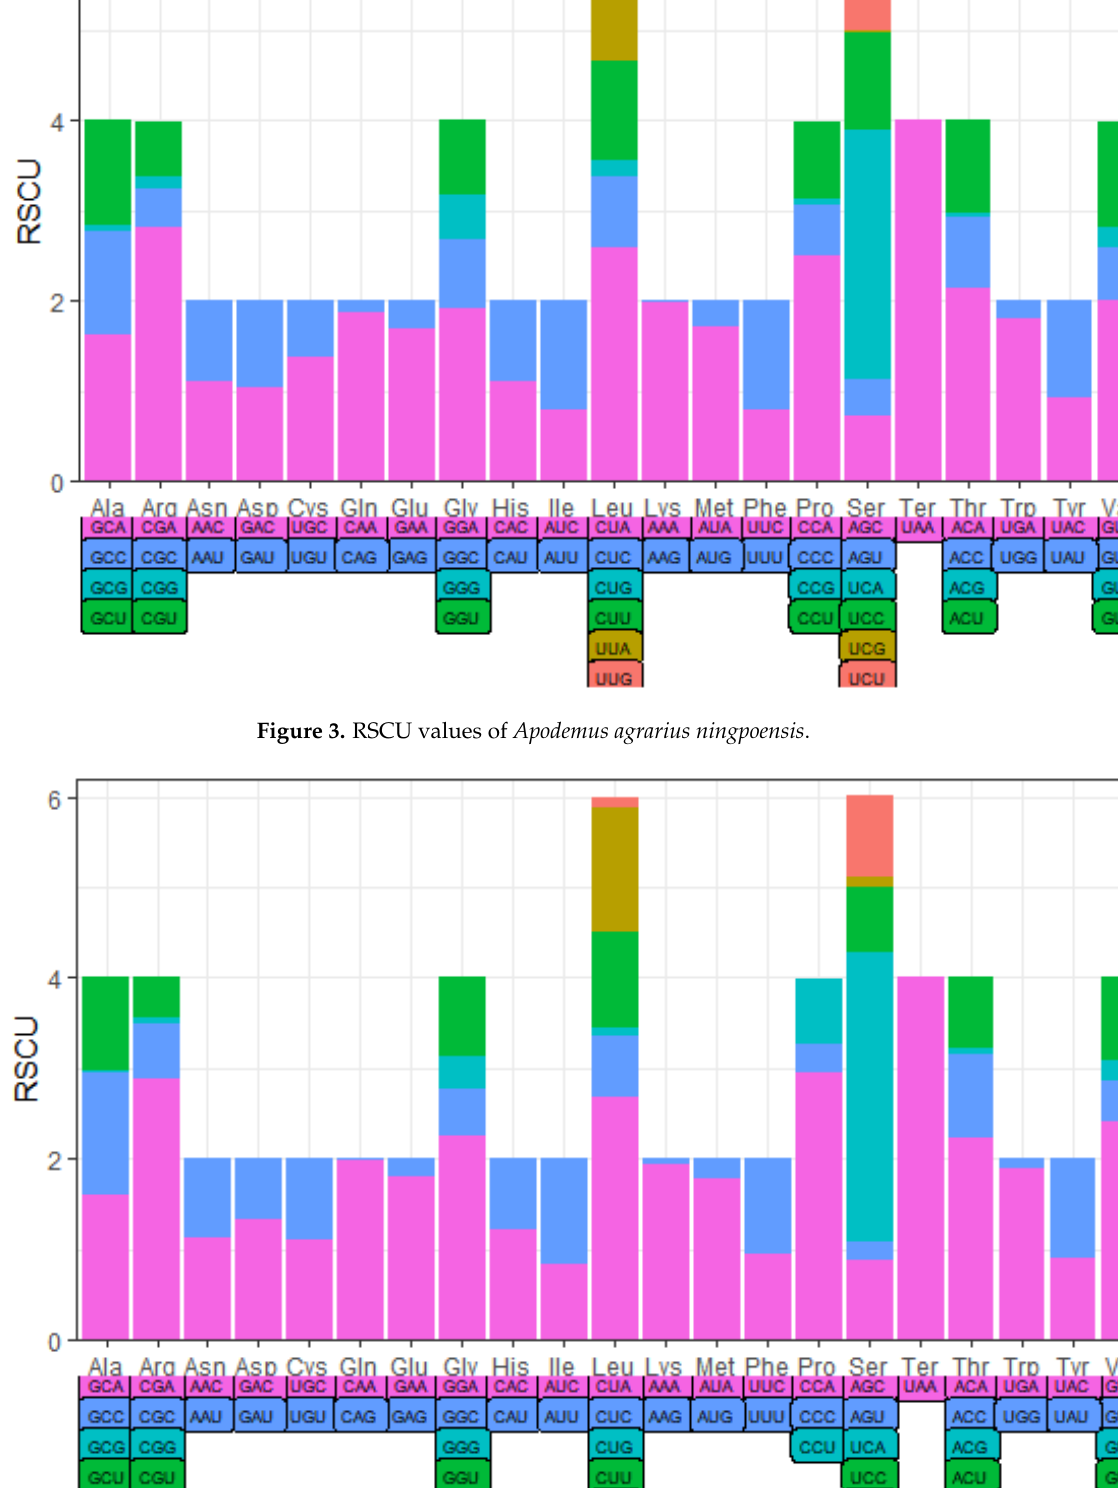
Figure 4. The RSCU values of Apodemus draco draco. We calculated the Ka/Ks values for 13 PCGs from 65 Muridae species (Figure 5). All Ka/Ks values were smaller than 1, indicating genes subjected to purification selection. In particular, the mean and median Ka/Ks values were the highest for ATP8 , suggesting that ATP8 had the highest evolution speed, the lowest for COX1 , indicating the slowest evolu ‐ tion. Figure 5. The Ka/Ks values for the 13 PCGs of 65 Muridae mitogenomes.